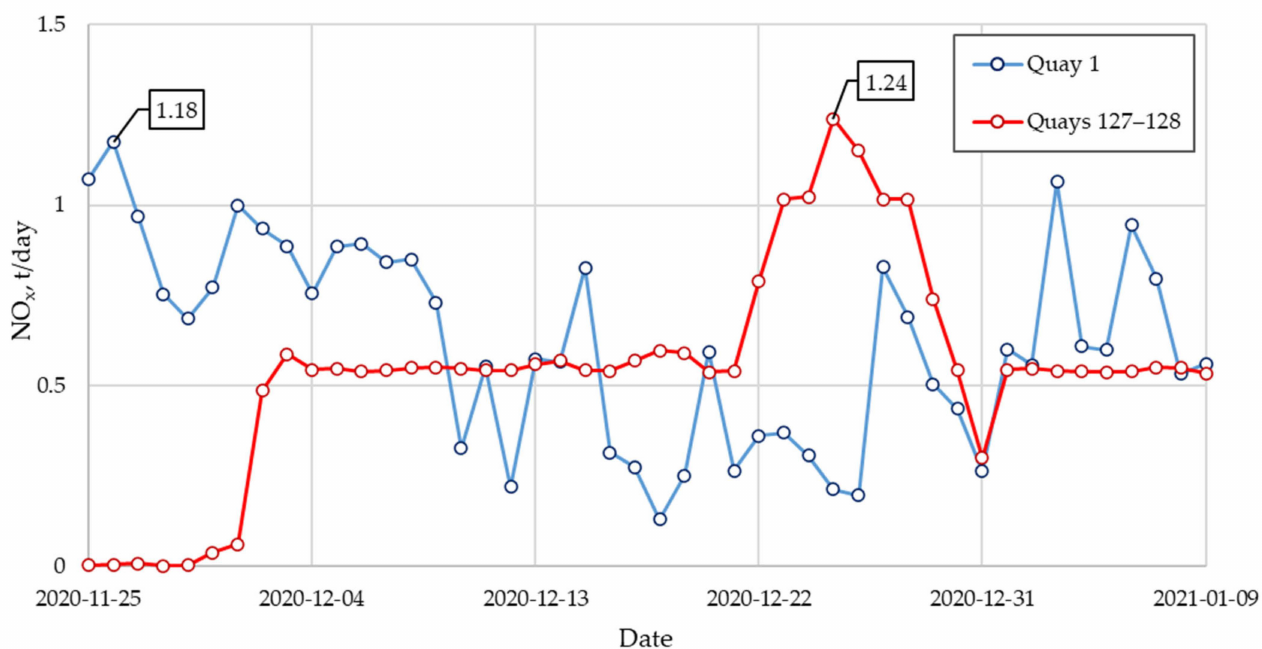
Figure 9. Distribution of NOx emissions on the quays 1 and